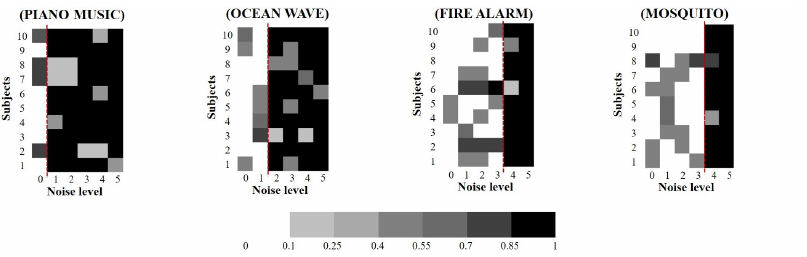
Figure 9. Clustering visualization results with comprehensive weighted degree based on DTF: A lighter block indicates a lower degree of subordination, and a deeper block indicates a higher degree of subordination. Red dashed lines represent the determination of clustering result.